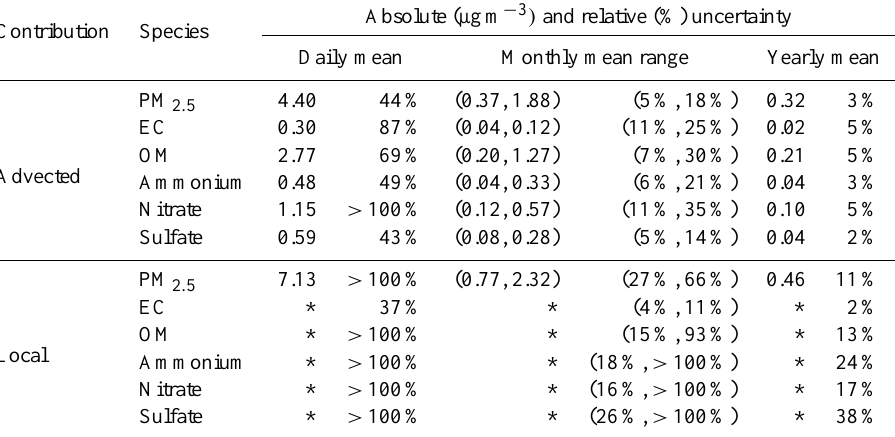
Table 3. Mean absolute and relative uncertainties on observed imported and local contributions at three time scales (see text for details), and range of uncertainties among all monthly contributions over the